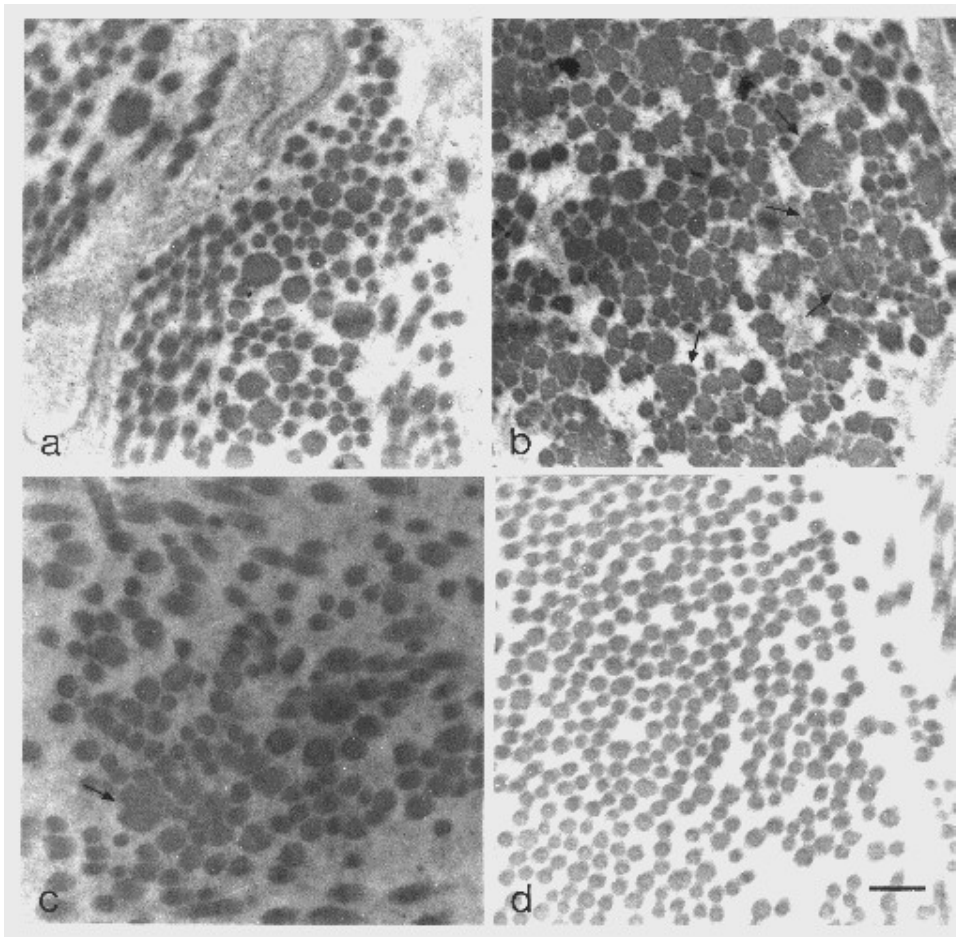
FIGURE 5 . Ultrastructure of collagen fibrils seen in cross-sections. In (a–c) the animals were injected for 30 consecutive days with 1.5 meq Li/kg and were sacrificed 6 months (a,b) and 12 months (c) after the last injection. The largest fibrils (indicated by arrows) are highly irregular with lobulated profile. These are compared with control fibril diameters (d). Bar = 0.3